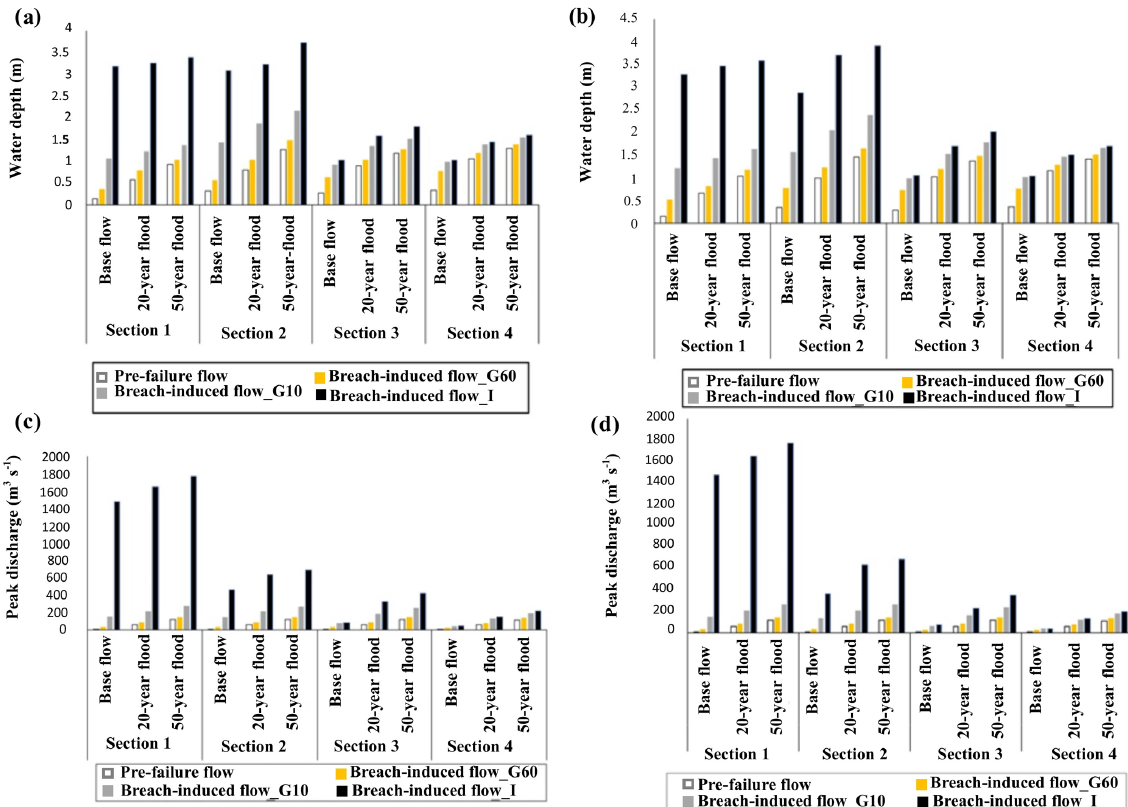
Figure 13. Computed maximum water depths (a, b) and peak discharges (c, d) in cross sections 1 to 4, for various pre-failure flow conditions (base flow, 20- and 50-year floods) and for roughness heights k s = 0 . 1m (a, c) or 0.3m (b, d) . “Breach-induced flow_G60”, “breach-induced flow_G10” and “breach-induced flow_I” stand for “flow induced by the failure of the landslide dam” with, respectively, a breaching time of 60min, a breaching time of 10min and an instantaneous